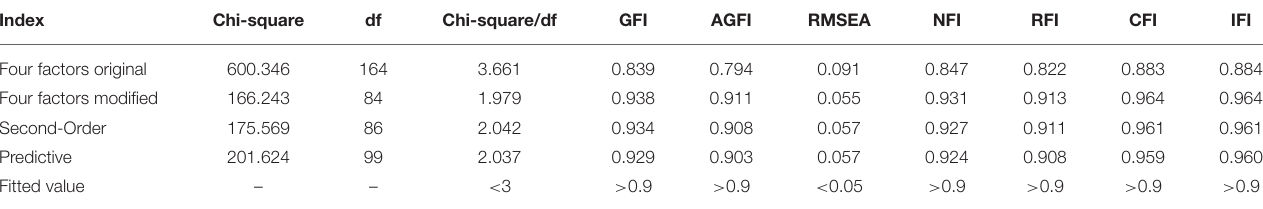
TABLE 2 | Results of the model fit